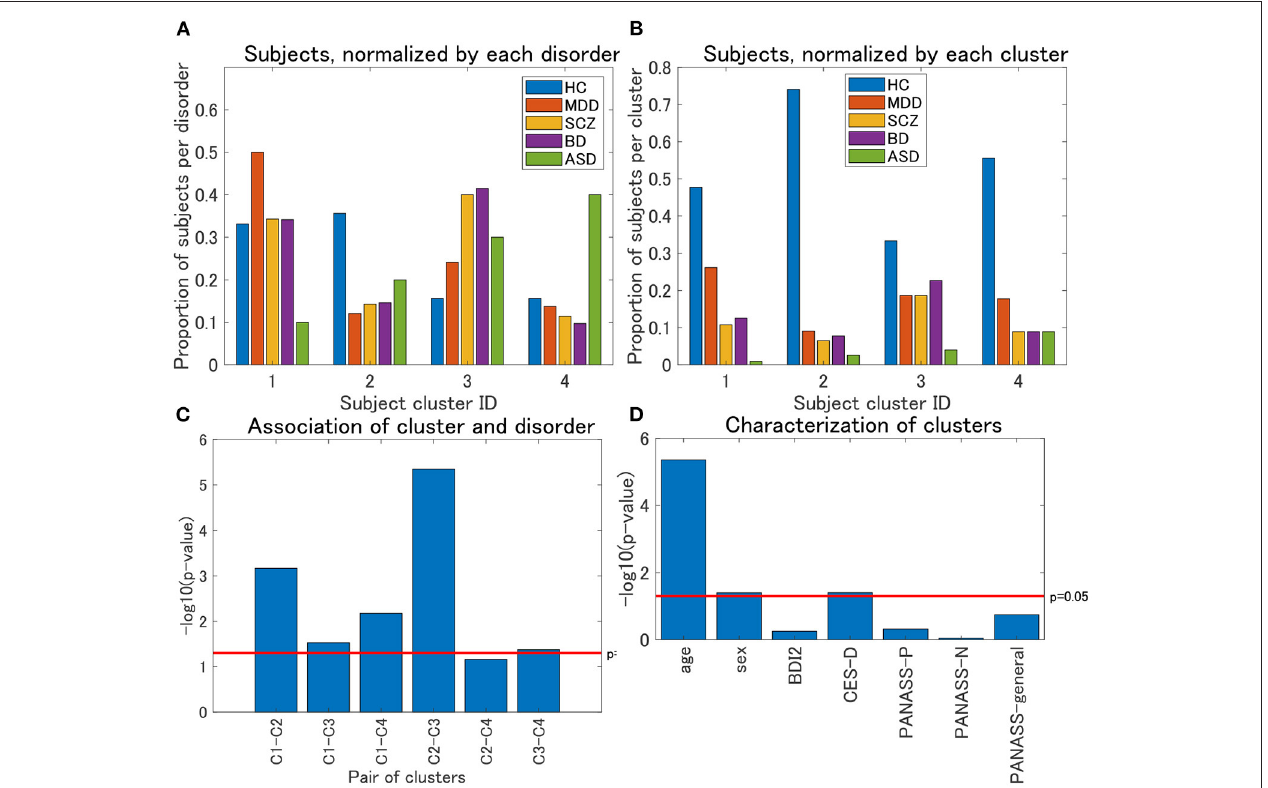
FIGURE 3 | (A) Distribution of subjects of UTO data for view 4, normalized by each disorder. The horizontal axis denotes the cluster ID, whereas the vertical axis denotes the proportion of subjects for each psychiatric disorder over all the four clusters. For each cluster, the proportion of subjects with a particular psychiatric disorder is denoted by a colored bar. Note that the proportion is evaluated in the disorder-wise manner. That is, the summation of the four proportions becomes one for each disorder (e.g., for HC, the summation of the proportions denoted by blue bars becomes one). Furthermore, note that clusters with < 10 subjects were removed. (B) Distribution of subjects of UTO data for view 4, normalized by each cluster. In contrast with (A) , the proportion of subjects is evaluated in a cluster-wise manner. That is, the summation of the five proportions becomes one for each cluster (e.g., for cluster 1, the summation of the proportions denoted in blue, red, orange, purple, and green becomes one). (C) Results of the χ 2 test for the association between pairs of cluster labels and pairs of psychiatric labels in view 4. For the pairs of psychiatric labels, we consider those psychiatric labels that characterize the pair of clusters in question. Namely, MDD and HC for clusters 1 and 2, MDD and SCZ/BD for clusters 1 and 3, MDD and ASD for clusters 1 and 4, HC and SCZ/BD for clusters 2 and 3, HC and ASD for clusters 2 and 4, and SCZ/BD and ASD for clusters 3 and 4. The horizontal axis denotes the pair of cluster labels, whereas the vertical axis denotes the negative logarithm of the p-value by the χ 2 test. (D) Characterization of four clusters in view 4. The horizontal axis denotes demographic/clinical indices, whereas the vertical axis denotes the negative logarithm of the p -value by the χ 2 test on cluster labels and sex, and the Kruskal-Wallis test on cluster labels and the remainder of the indices. BDI2, beck depression inventory II; CES-D, center for epidemiologic studies depression scale; PANASS-P, positive and negative syndrome scale consisting of positive psychopathology scale; PANASS-N, negative scales; PANASS-general, general